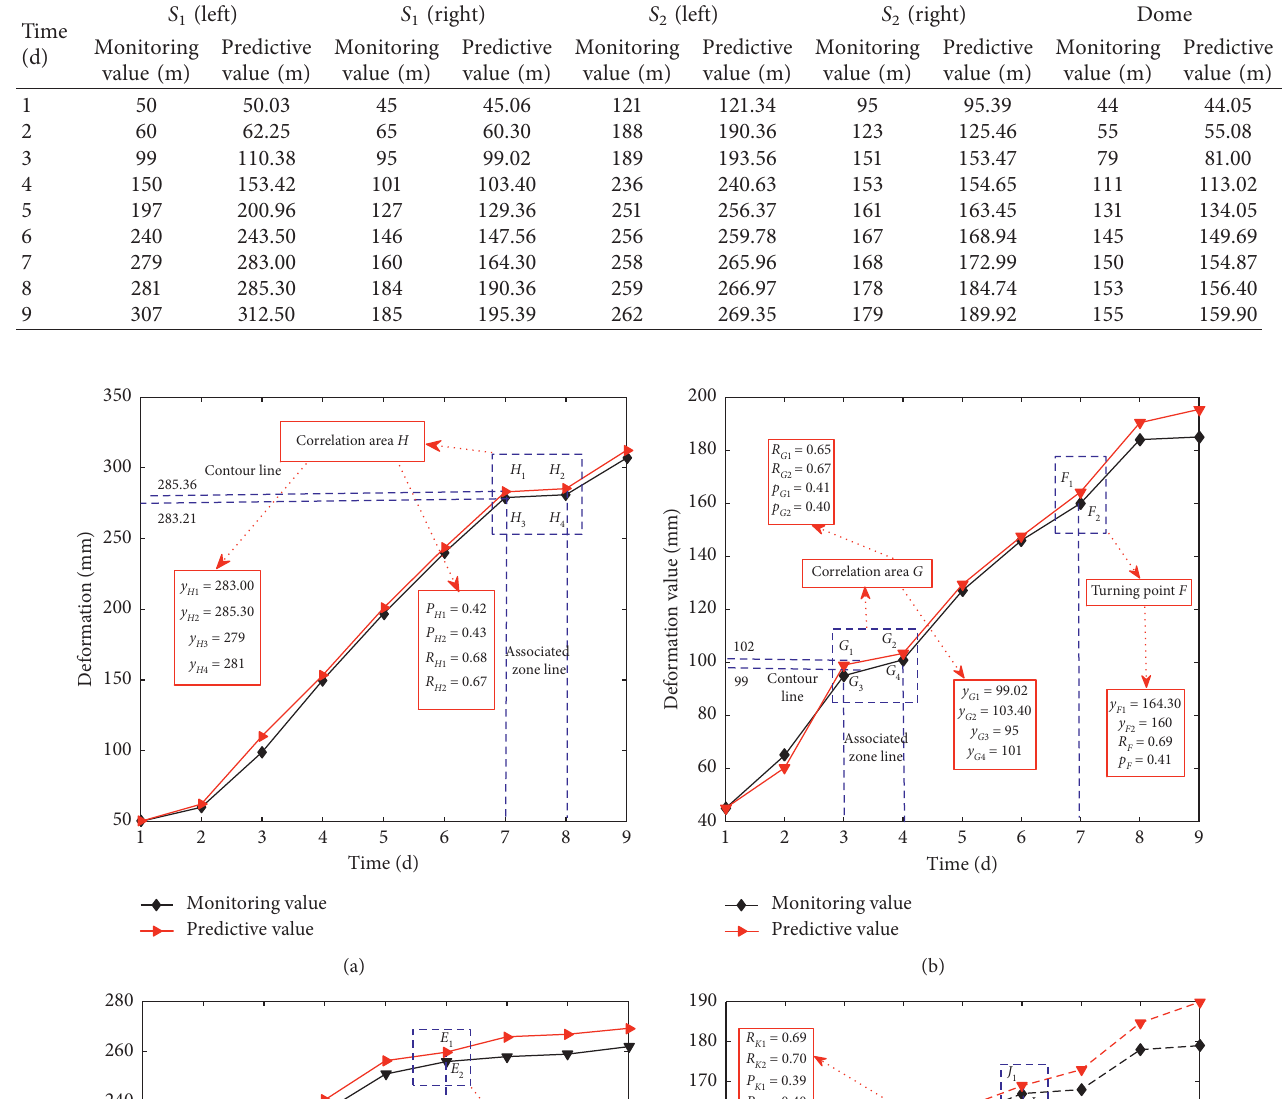
Table 1: Tunnel deformation monitoring